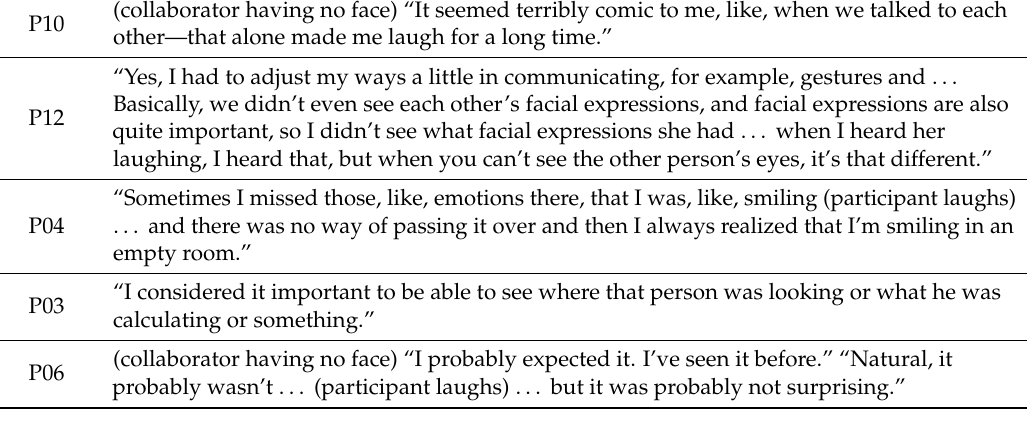
Table 5. Verbatim excerpts of statements by participants: Absence of avatar faces and invisibility of